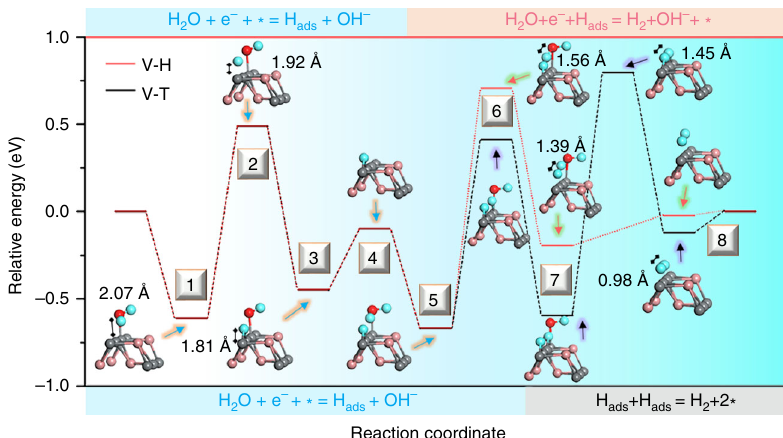
Fig. 5 Schematic con fi guration-coordinate diagrams for the HER mechanism. Free energy vs. the reaction coordinates of HER for Volmer – Heyrovsky (V – H) and Volmer – Tafel (V – T) process. (Fe, gray spheres, S, pink spheres, H, blue spheres, O, red